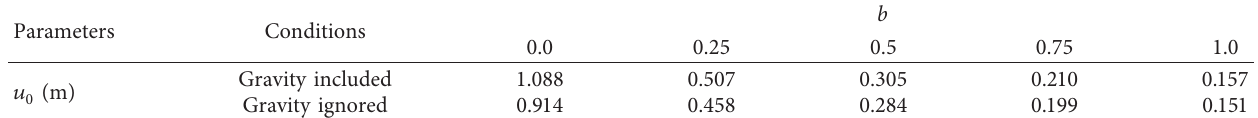
Figure 5: GRC at different gravity condition and intermediate principal stress. (a) Ignoring the gravity effect. (b) Considering the gravity effect. Table 3: Roof surface displacement of the tunnel under various gravity conditions.